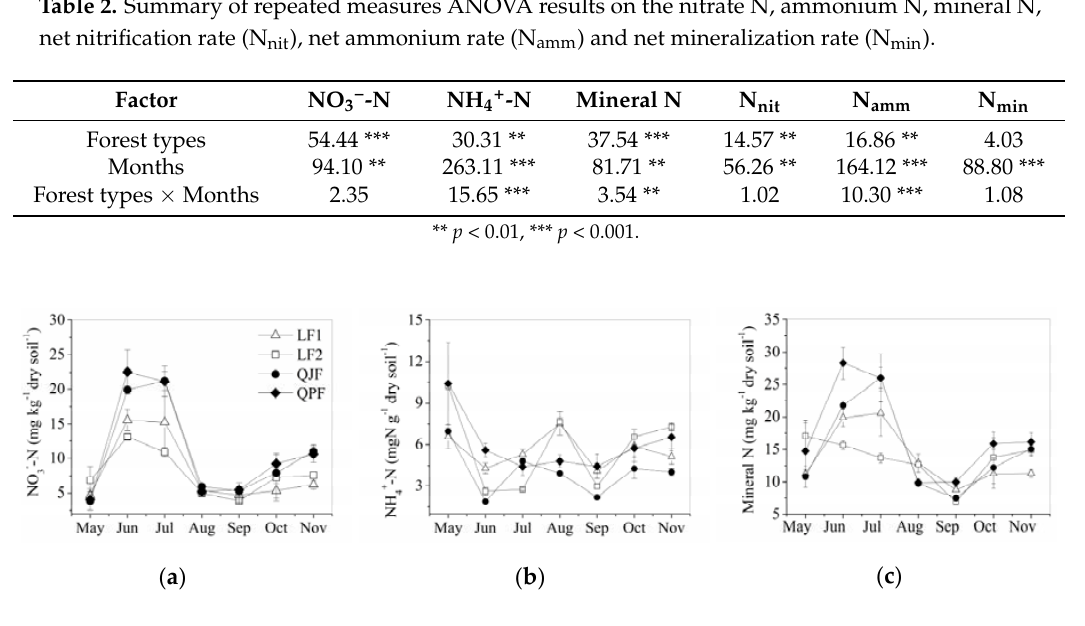
Figure 2. Dynamics of NO 3 − -N ( a ) and NH 4+ -N ( b ) and inorganic N ( c ) concentrations in LF1, LF2, QJF and QPF (means ± SE, n = 3).